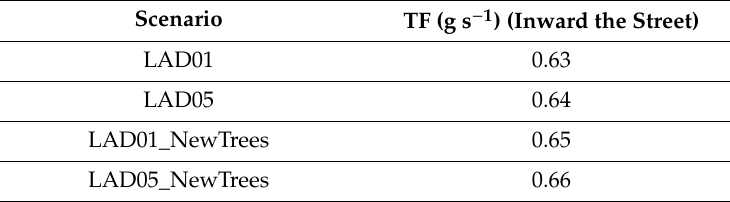
Table 5. Total pollutant fluxes inward on the study